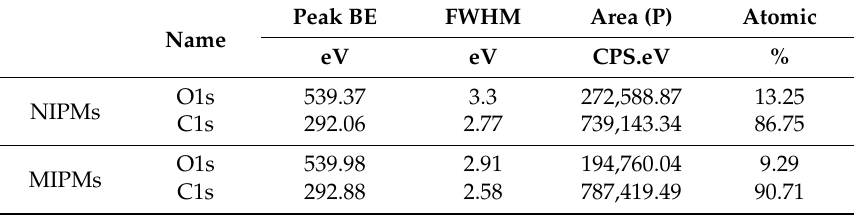
Figure 6. ( a – d ) XPS spectra of the prepared NIPMs and MIPMs samples: ( a ) XPS survey spectra, ( b ) comparison on the oxygen atomic percentage based on the XPS survey spectra between the NIPM and MIPM samples, and ( c , d ) high-resolution XPS C1s ( c ) and O1s ( d ) core-level spectra. Table 2. Summary of the information obtained for NIPMs and MIPMs based on the corresponding XPS survey spectra, including peak position, full width at half maximum (FWHM), peak area, and atomic percentages of carbon and